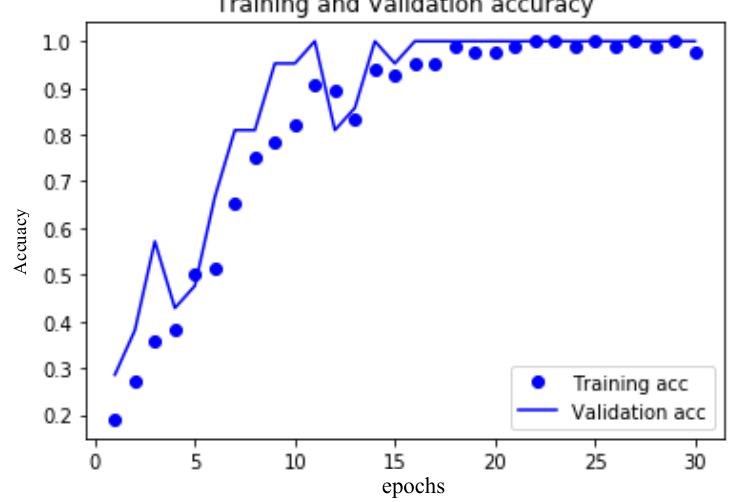
Figure 8. Accuracy of feature selection of PCA 24 of epoch 30.